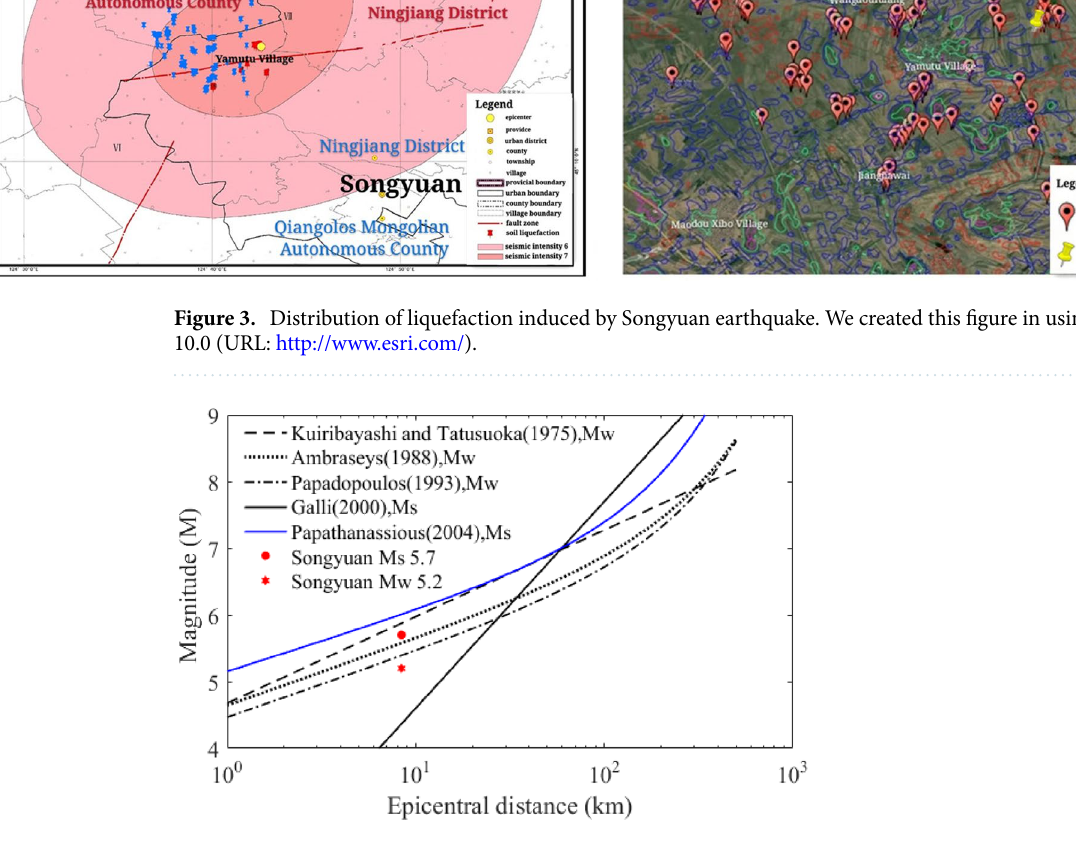
Figure 4. Comparison among the different curves about magnitude and maximum epicentral distance of liquefied sites provide by previous authors (The two dots represent the surface wave magnitude and the moment magnitude of this earthquake).